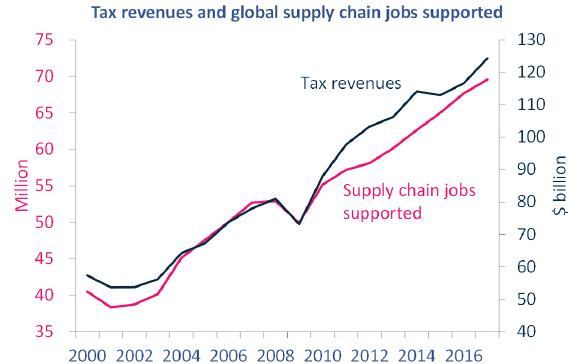
Figure 2. Global tax revenues gained from activities of airlines